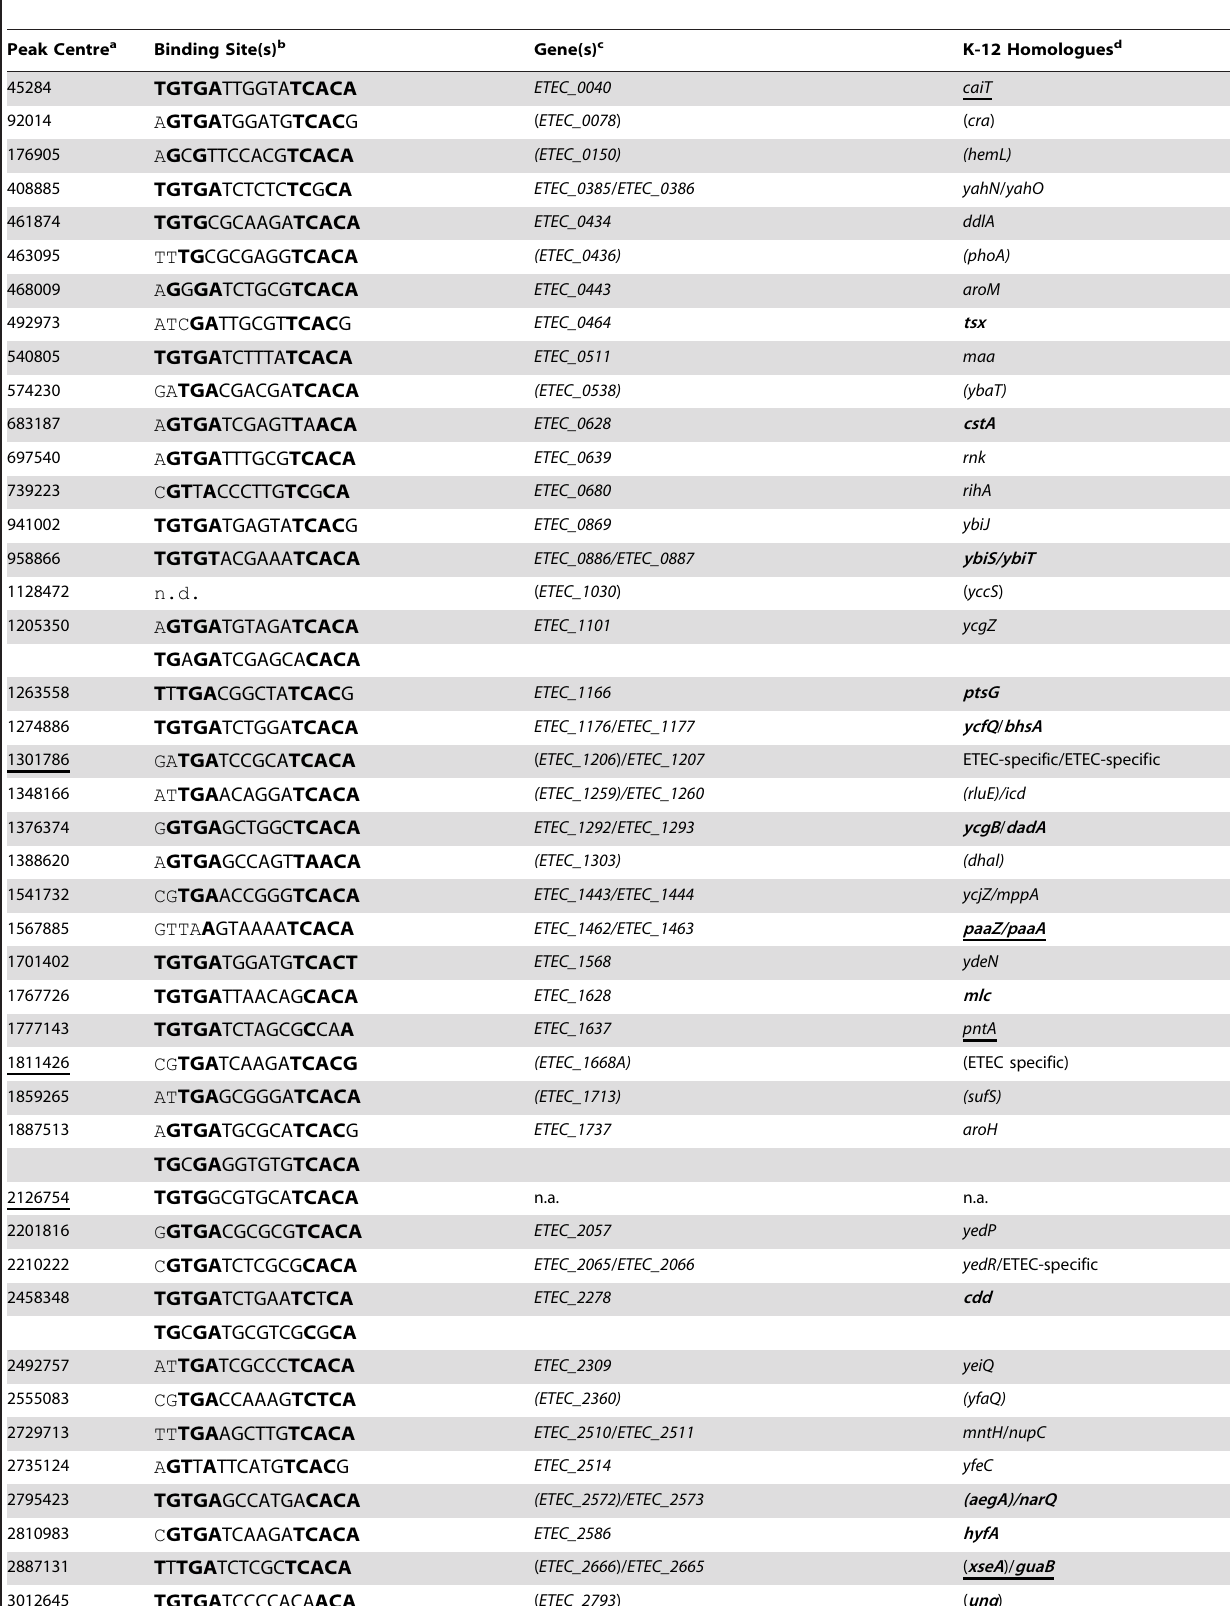
Table 1. High-confidence CRP binding sites on the ETEC H10407 chromosome identified by ChIP-seq.